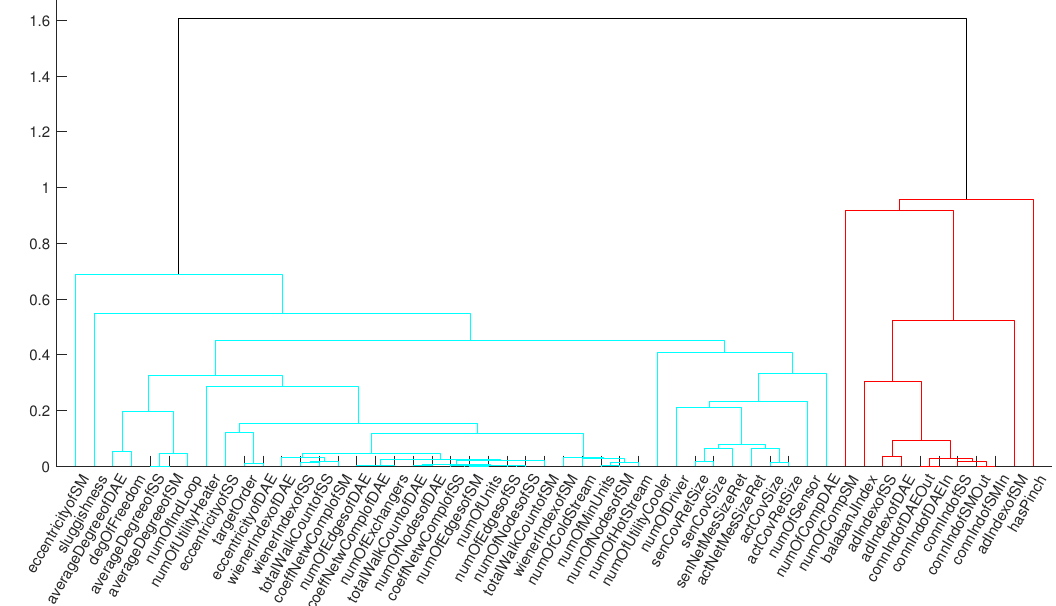
Figure 10. Correlations between the measures. Dendrogram presenting the distances between the measures for all unique HENs.